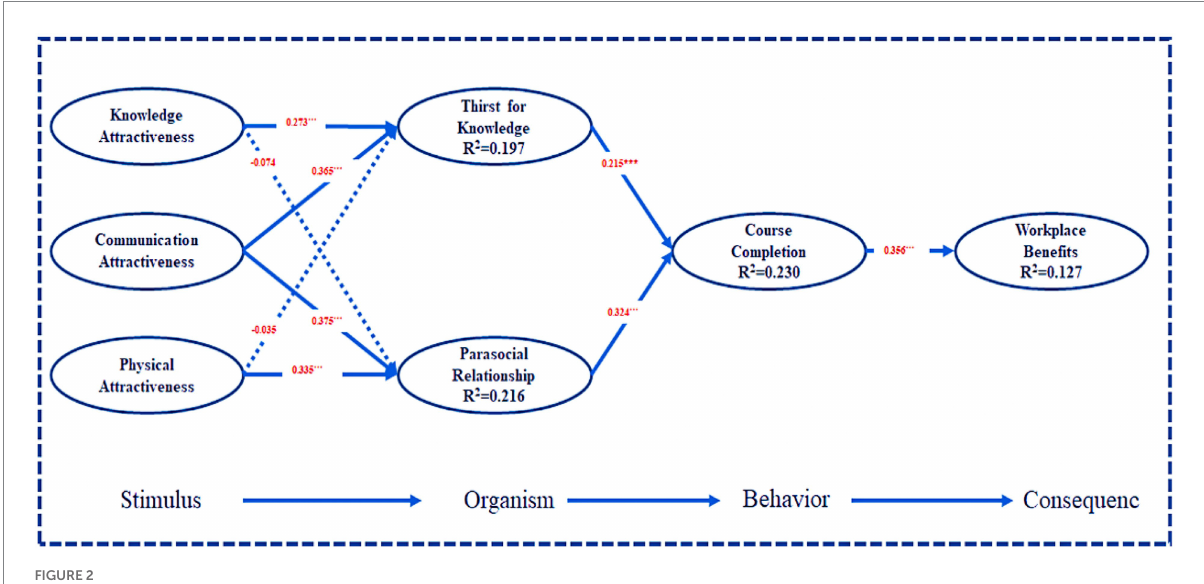
FIGURE 2 Test results of the structural model test. Note: *** p < 0.001, ** p <